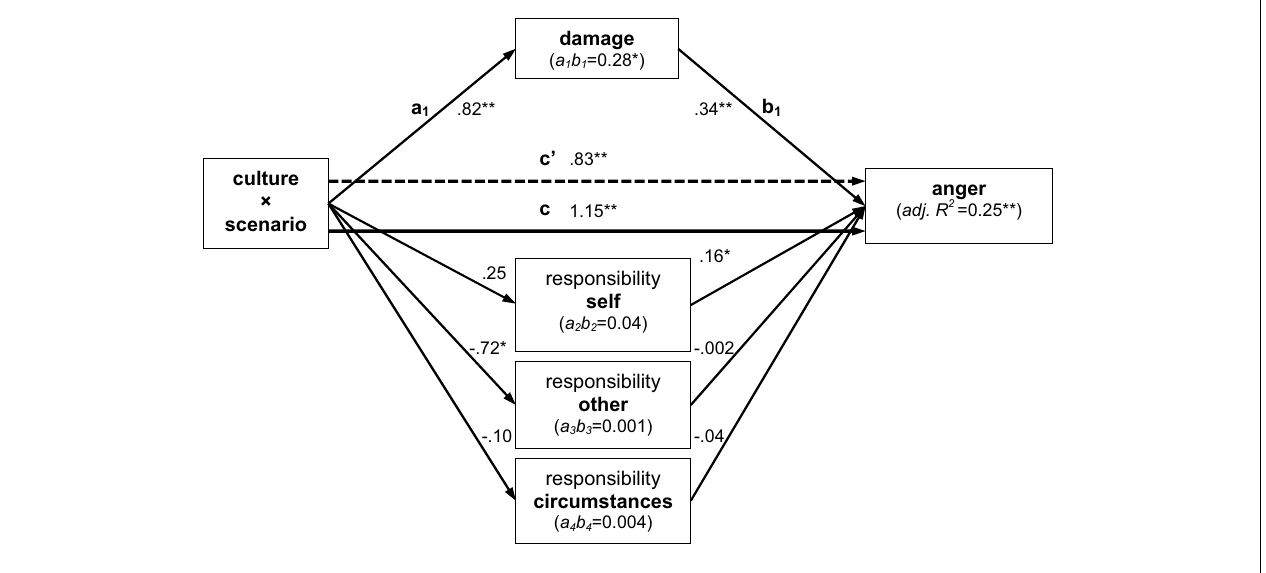
their respective arrows; indirect effects ( a i b i ) are indicated inside the mediator boxes; proportion of explained variance is indicated for the dependent variable anger. All values reflect normal-theory based testing, but were verified by additional randomization analyses with 10,000 bootstraps. Single asterisks indicate 0.0001 ≤ p < 0.05, double asterisks p <